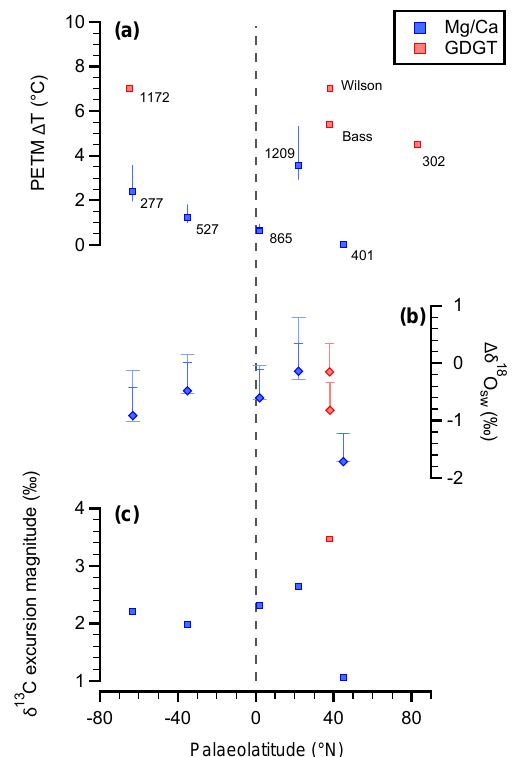
Figure 7. Compiled sea surface temperature and δ 18 O sw peak- PETM shifts relative to pre-CIE values. Panel (a) : GDGT and Mg / Ca-derived warming as a function of latitude. Mg / Ca esti- mates are adjusted for both pH and the sensitivity of the Mg / Ca– temperature relationship in PETM seawater (see text for details) and are the average of estimates derived from the two surface- dwelling foraminifera genera Morozovella and Acarinina . Labels refer to ODP and DSDP site numbers or locality names. Panel (b) : (cid:49)δ 18 O sw reconstructions based on foraminifera δ 18 O coupled with either Mg / Ca or GDGT-derived sea surface temperature shifts. δ 18 O was adjusted for pH following Uchikawa and Zeebe (2010). Inner error bars are the uncertainty relating to the δ 18 O–pH slope (data points use the δ 18 O–pH slope of G. bulloides , whilst the in- ner positive error bar shows where the data would lie if the slope of O. universa were to be used); outer error bars also include the uncertainty relating to the pH and sensitivity corrections applied to the Mg / Ca data. Data not specifically discussed in the main text are from Sluijs et al. (2006) and Sluijs et al. (2011). Panel (c) : the magnitude of the carbon isotope excursion at each site in Acarinina , with the exception of DSDP Site 401 ( Morozovella